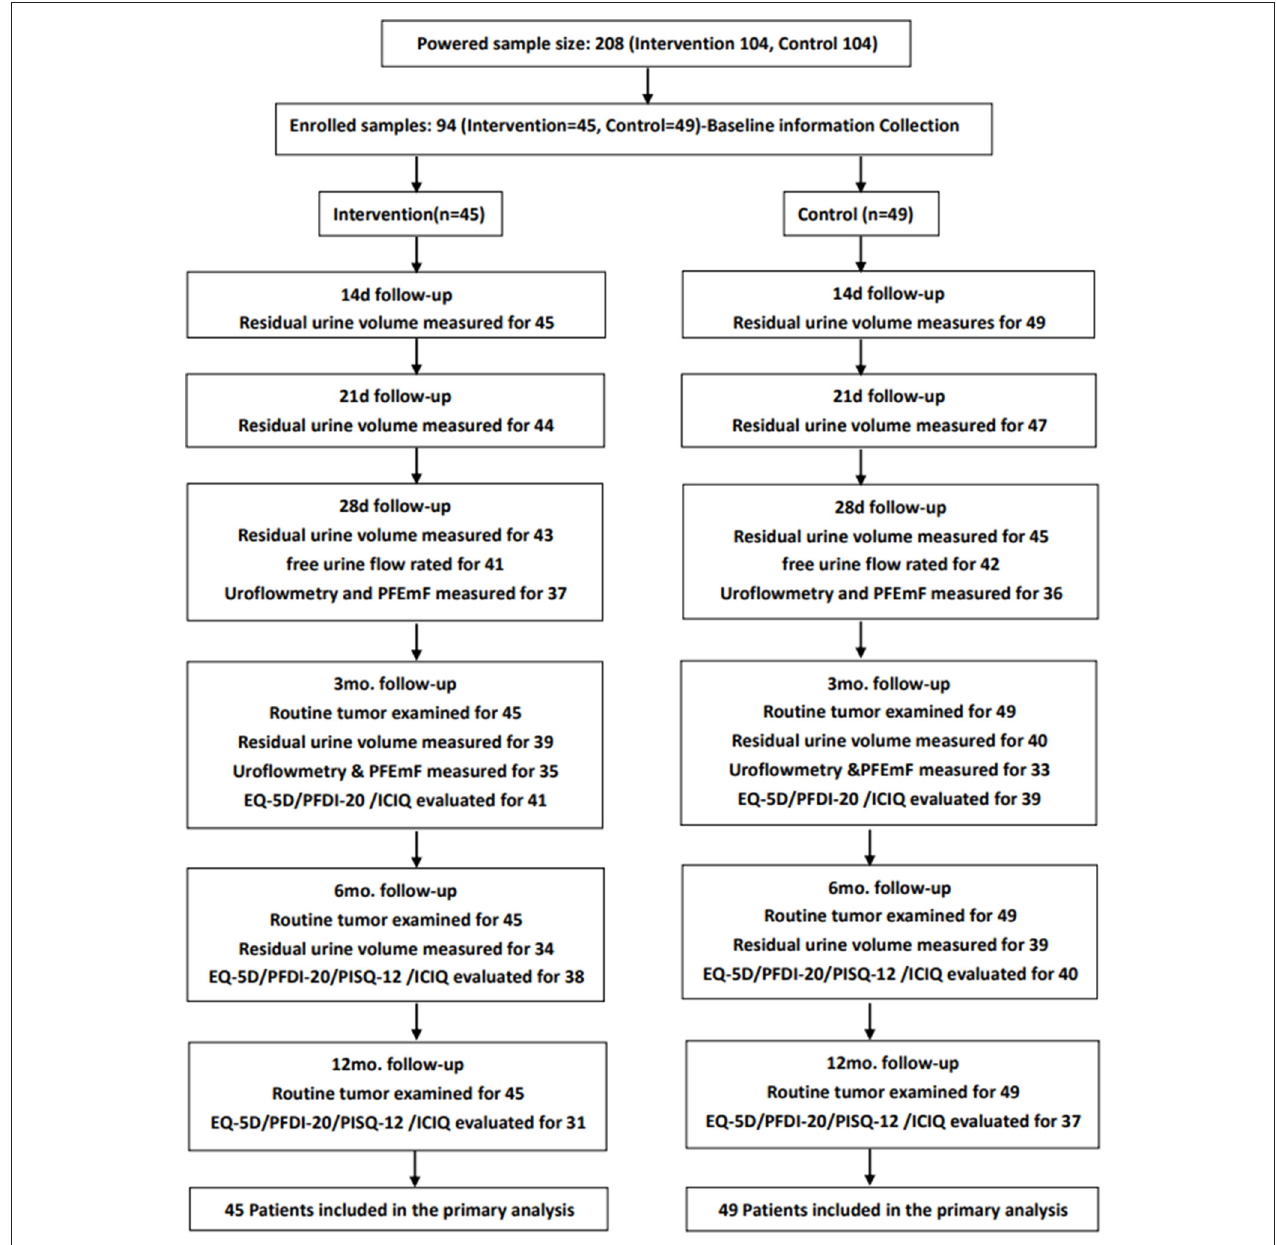
FIGURE 1 | The trial profile of the study: Routine tumor examination, baseline information, gynecological examination (Human Papillomavirus and Thinprep Cytological Testing), tumor markers (squamous cell carcinoma antigen, CA125, CA199, carcinoembryonic antigen), CT or MRI examination, chest radiograph, etc.